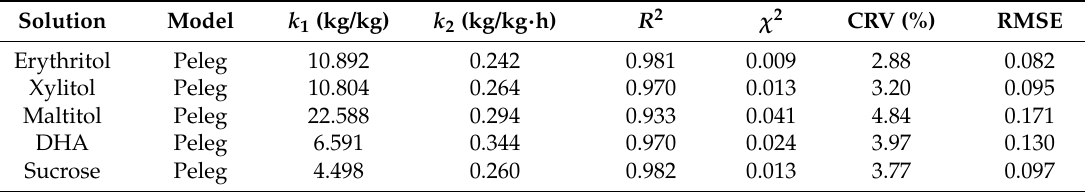
Table 2. The values of k 1 , k 2 , R 2 , χ 2 , coefficient of residual variation (CRV) and root mean square